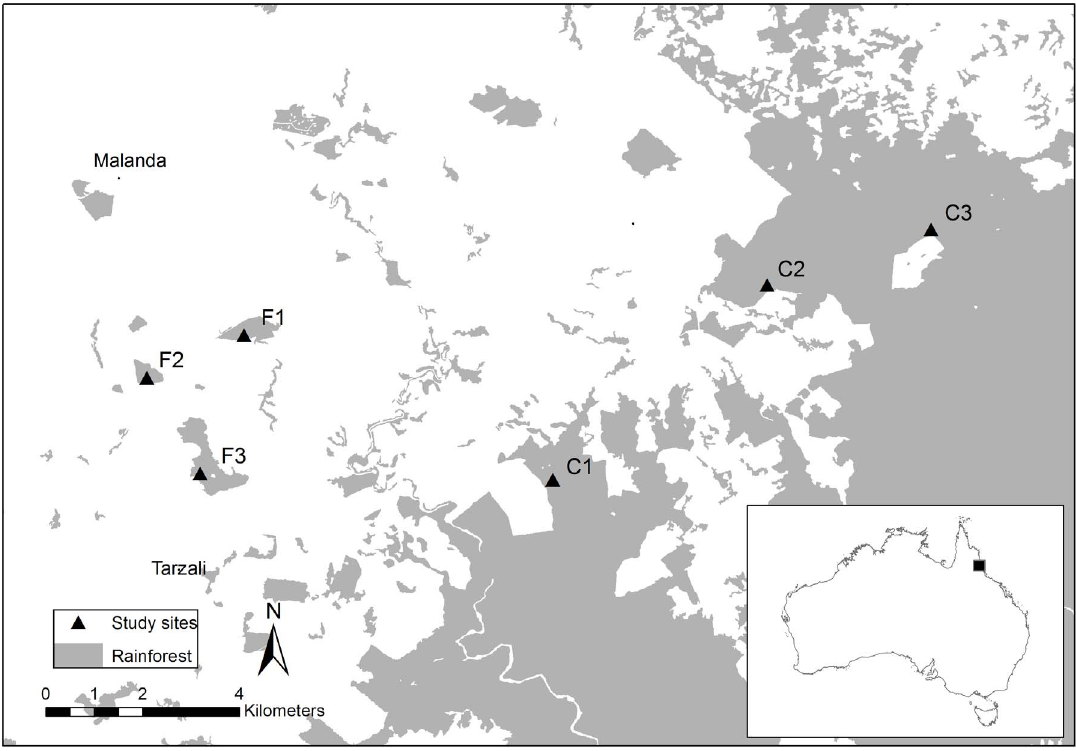
Figure 1. The distribution of fragmented (F1–F3) and continuous rainforest (C1–C3) study sites on the Atherton Tablelands in north-eastern Australia.